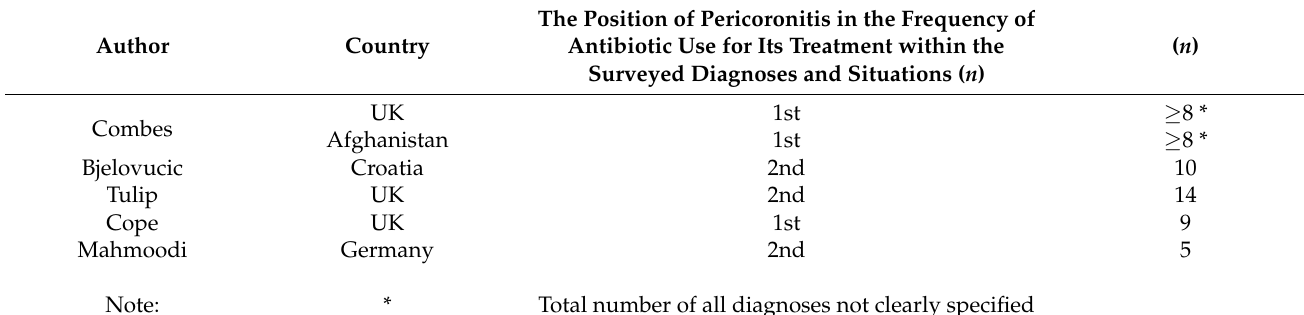
Table 11. The position of pericoronitis in the frequency of antibiotic use for its treatment within the surveyed diagnoses and situations.